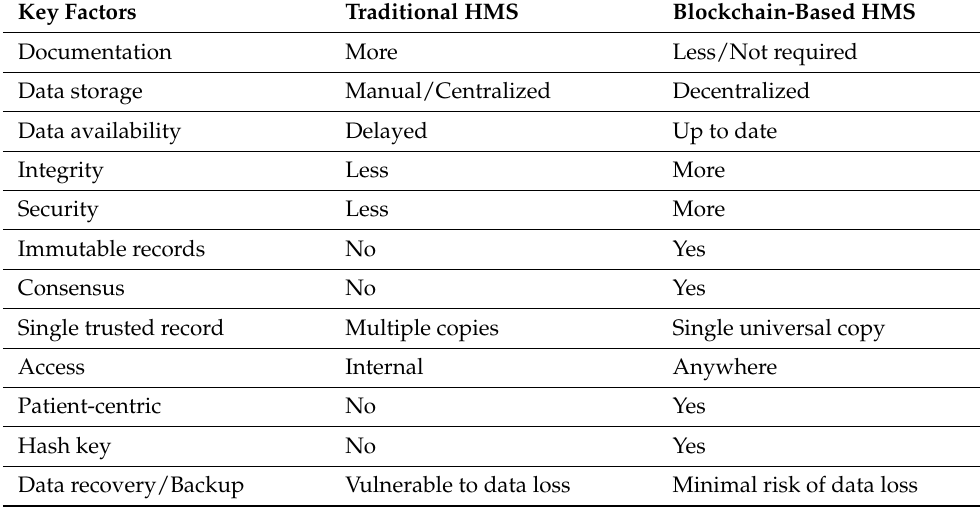
Table 6. Traditional HMS and blockchain-based